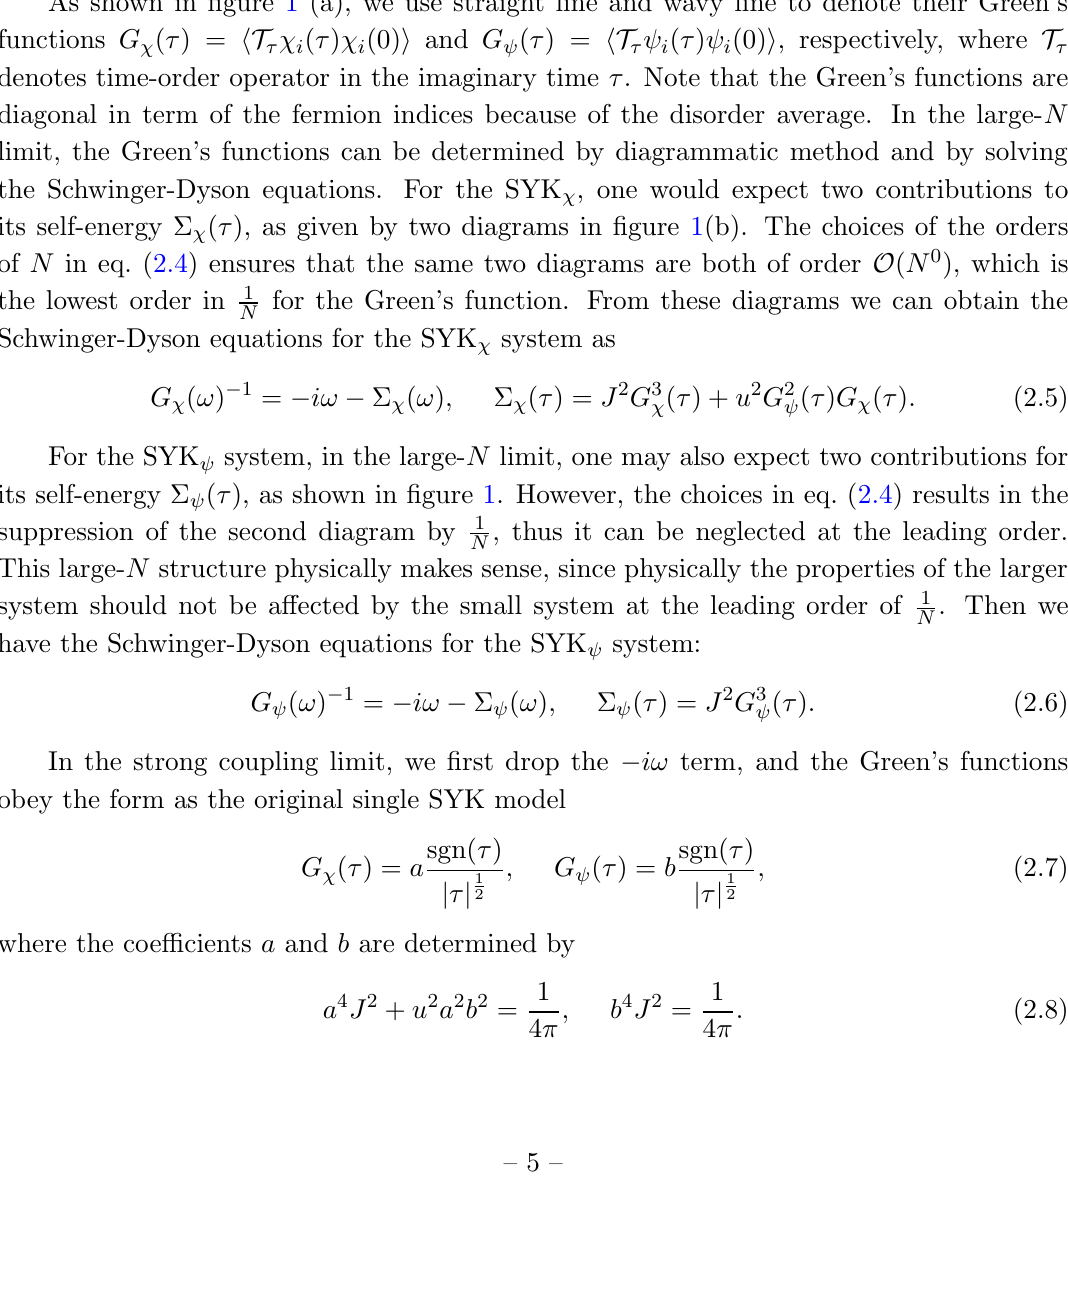
(cid:2) N 3 (cid:24) O ( N 0 ); right: (cid:24) u 2 (cid:2) N (cid:2) N 3 N 5 (cid:2) ( N 2 ) 3 (cid:24) O ( N 0 ); right: (cid:24) u 2 (cid:2) N 2 (cid:2) N 2 (cid:24) O ( 1 N 6 N 5 N